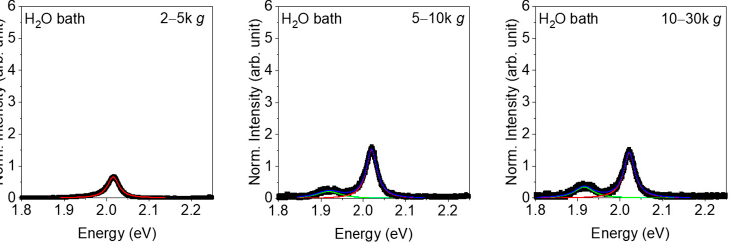
Figure A8. Photoluminescence spectra ( λ exc = 532 nm) the WS 2 nanosheet dispersions, exfoliated by tip sonication with a 30% amplitude. The bulk starting material was stirred in hexane/ n -BuLi prior to exfoliation. The PL was fitted by Lorentzians for quantitative analysis.